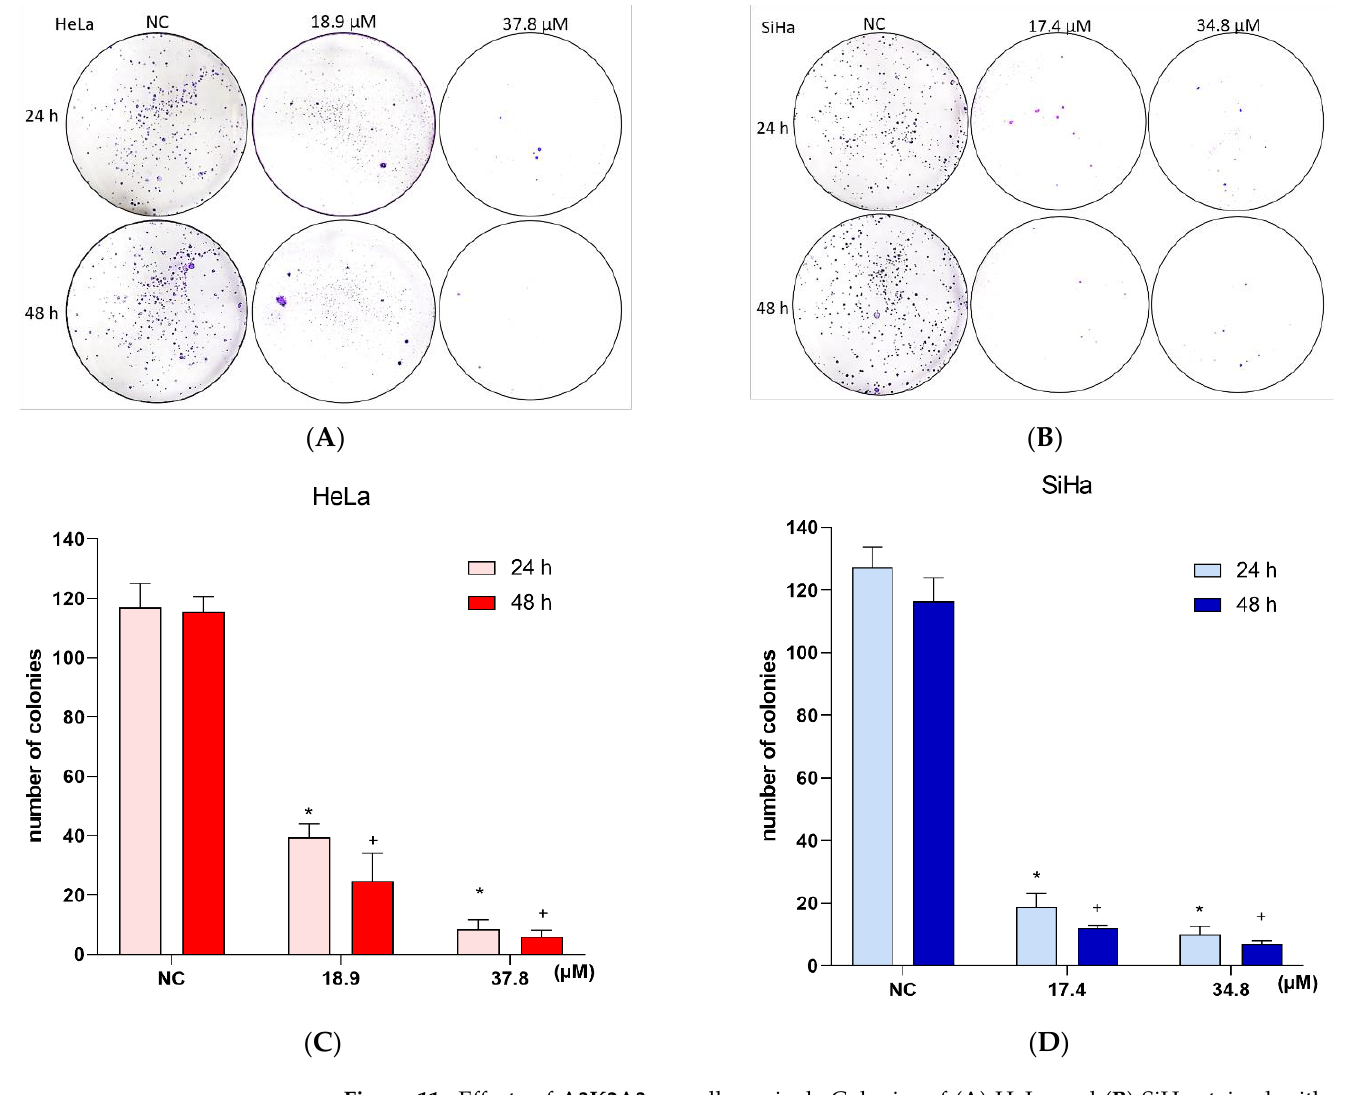
Figure 11. Effects of A3K2A3 on cell survival. Colonies of ( A ) HeLa and ( B ) SiHa stained with Giemsa in 6-well plates. Quantification of the number of colonies in relation to the NC ( C ) HeLa and ( D ) SiHa. Cells were treated with A3K2A3 (IC 50 or 2xIC 50 ) for 24 and 48 h. Colonies were counted and plotted on graphs showing the average number of colonies for the NC versus treated cells. A cluster of cells was considered a colony when it contained more than 50 cells. The bars represent the mean ± SD of three independent experiments that were performed in triplicate. ( C , D ) * p < 0.05 compared to 24 h NC, + p < 0.05 compared to 48 h NC (two-way ANOVA followed by Tukey ’ s post- test).